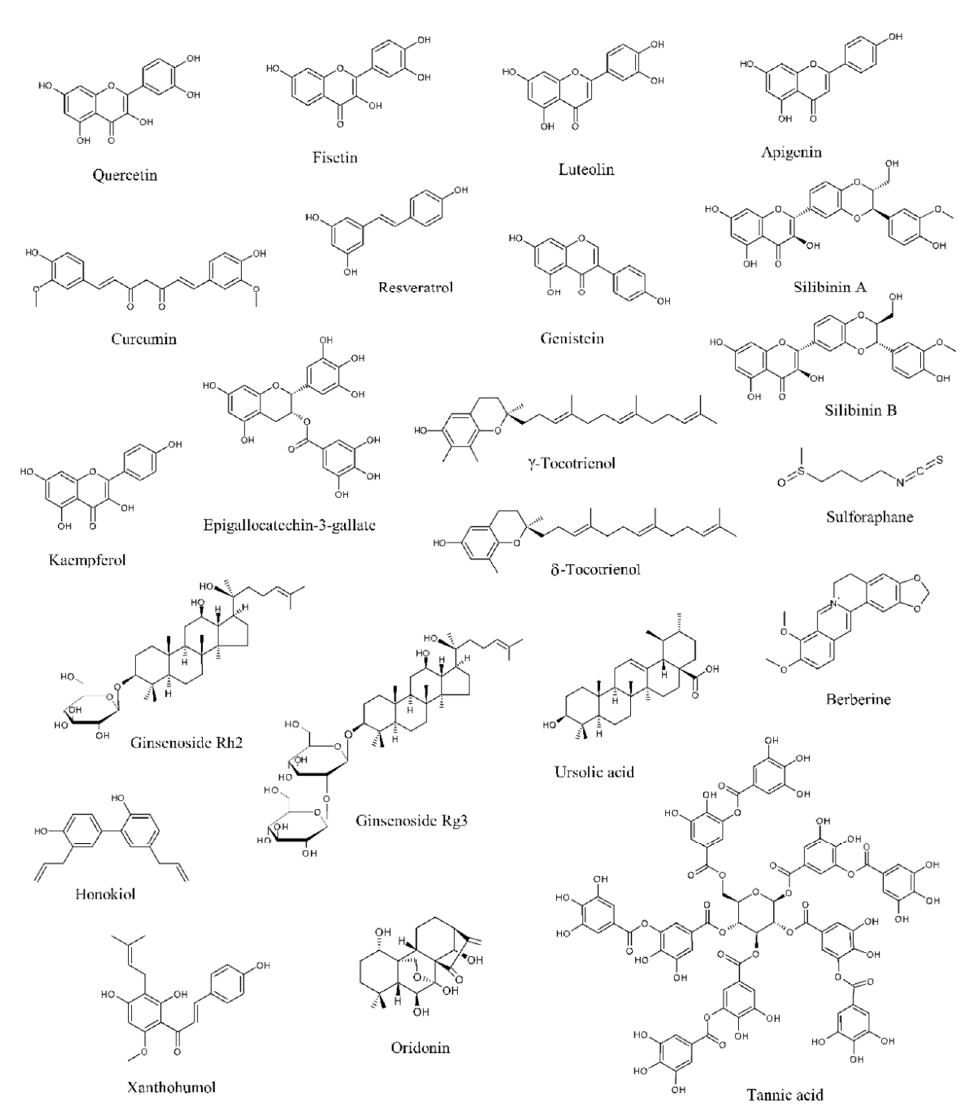
Figure 1. Chemical structures of the major anti-prostate cancer (PCa) phytochemicals.